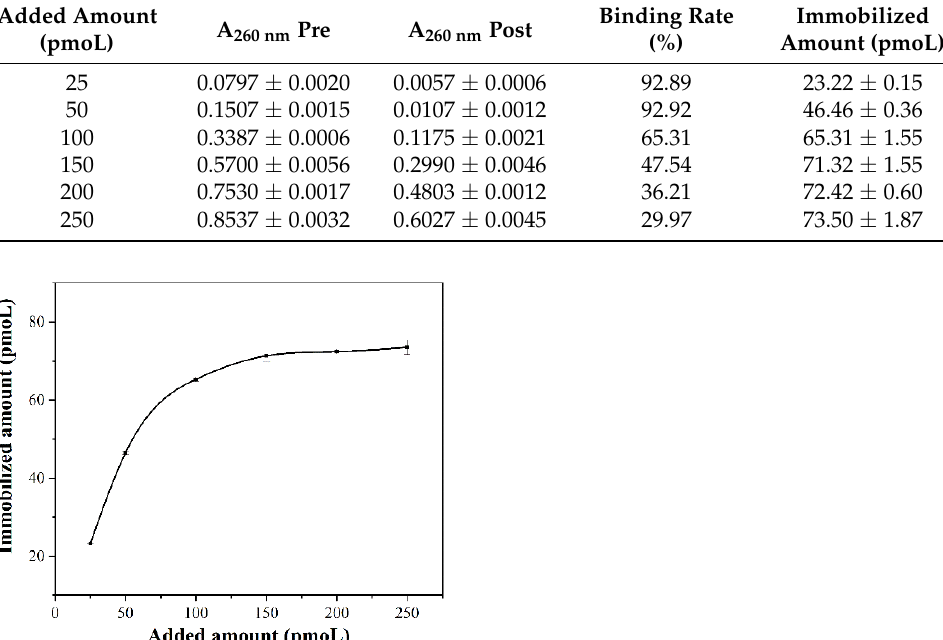
Table 2. The absorbance value of biotin-probe solution before and after binding to the magnetic particle.